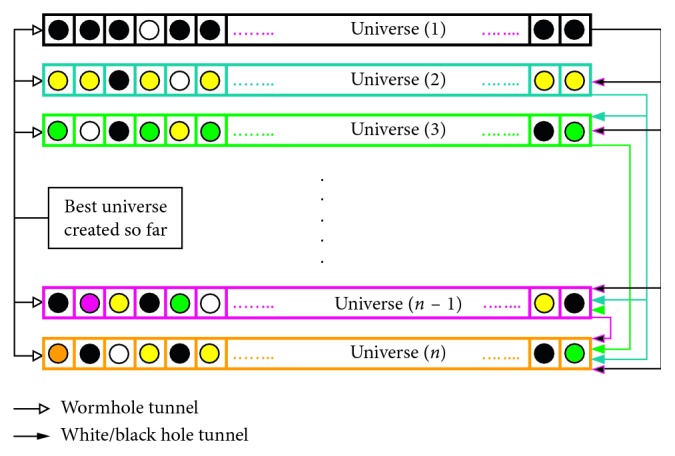
A sketch of MVO [31].